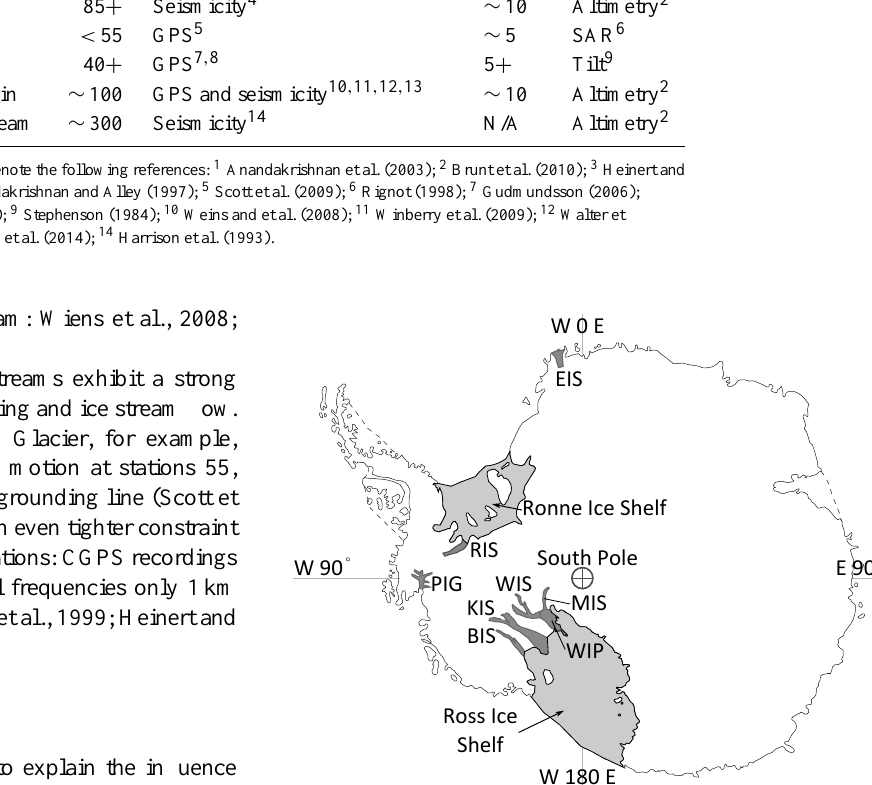
Whillans Ice Stream ∼ 300 Seismicity 14 Altimetry 2